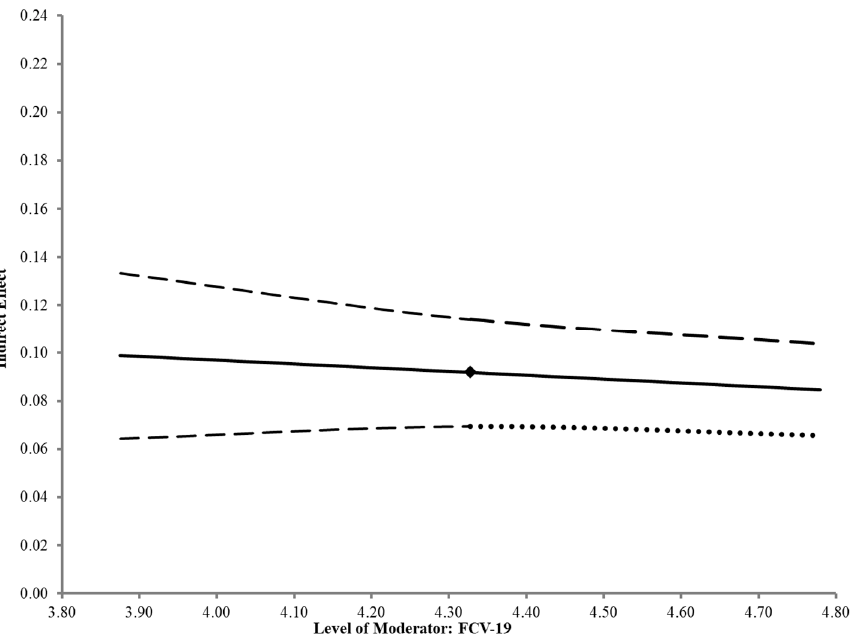
Figure 3. Effect of fear of economic crisis on perceived job insecurity through mental health at levels of FCV ‐ 19.